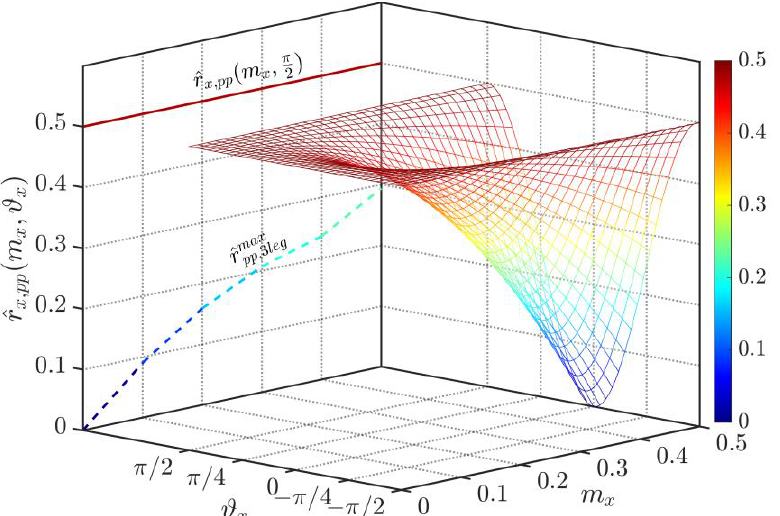
Figure 3. Normalized, peak-to-peak, phase current ripple as a function of the modulation index m x , and phase angle ϑ x . On the left-hand side, a comparison of the normalized maximum peak-to-peak values in the case of three-phase three-leg (“ 3leg ”) and three-phase split-capacitor converters.